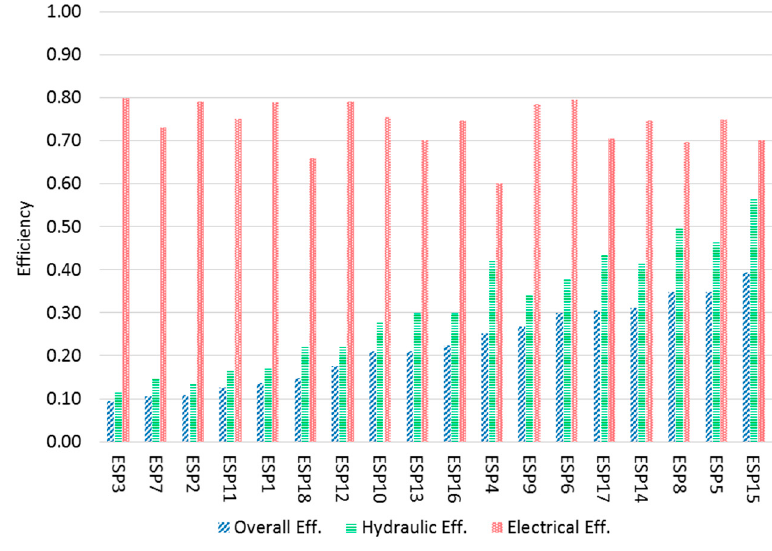
Figure 9. ESP Hydraulic, electrical, and overall efficiencies.